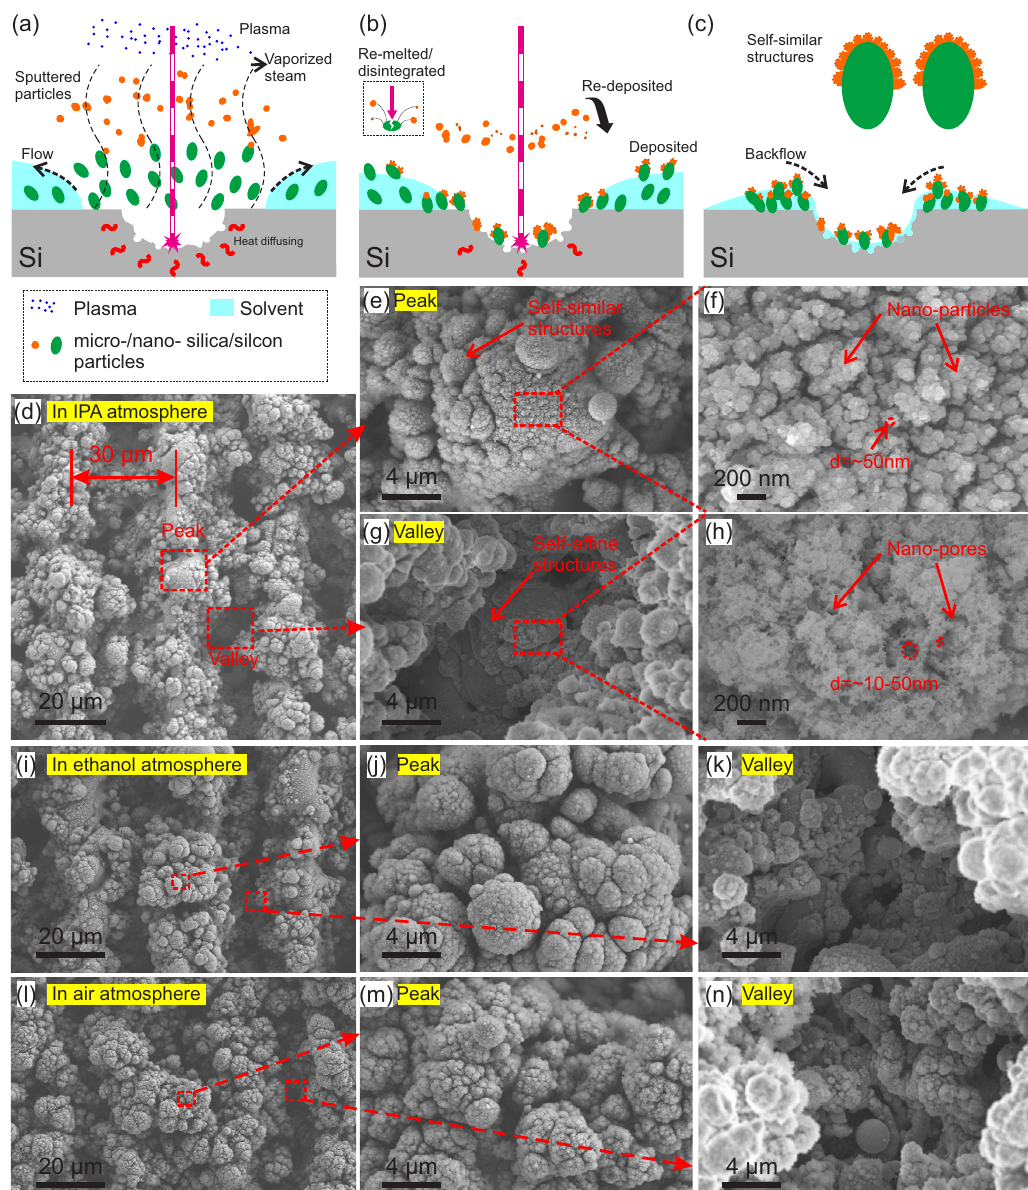
Figure 2. Mechanism of self-similar hierarchical micro–nano structure formation and more detailed micro-views. ( a – c ) Schematics of texture forming process on black Si: ( a ) Laser ablating Si surface that led to sputtered particles, vaporized plasma, and plasma; ( b ) re-melted and disintegrated particles under pulsed laser beam and hierarchical structures that were generated due to depositing and re-depositing; ( c ) solvent flowing back and self-similar hierarchical structure stacking. ( d – h ) Field scanning electron microscopy (FSEM) images of a black Si sample under v = 15 mm / s and ∆ L = 0.03 mm in the IPA atmosphere: Micro-view of surface topography containing microgrooves ( d ); the magnified image of a “peak” with several broccoli-like structures ( e ); a further amplified micro-view of a broccoli-like structure that is rich in nano-particles ( f ); the magnified image of a “valley” with several broccoli-like structures ( g ); a further amplified micro-view of a broccoli-like structure that is rich in nano-pores and nano-particles ( h ). ( i – k ) FSEM images of a black Si sample with the same parameters as the above but in an ethanol atmosphere: Overview in ( i ) and magnified views of a “peak” ( j ) and “valley” ( k ) that contained abundant broccoli-like structures. ( l – n ) FSEM images of a black Si sample with the same parameters as the above but in an air atmosphere: Overview in ( i ) and magnified views of a “peak” ( j ) and “valley” ( k ).